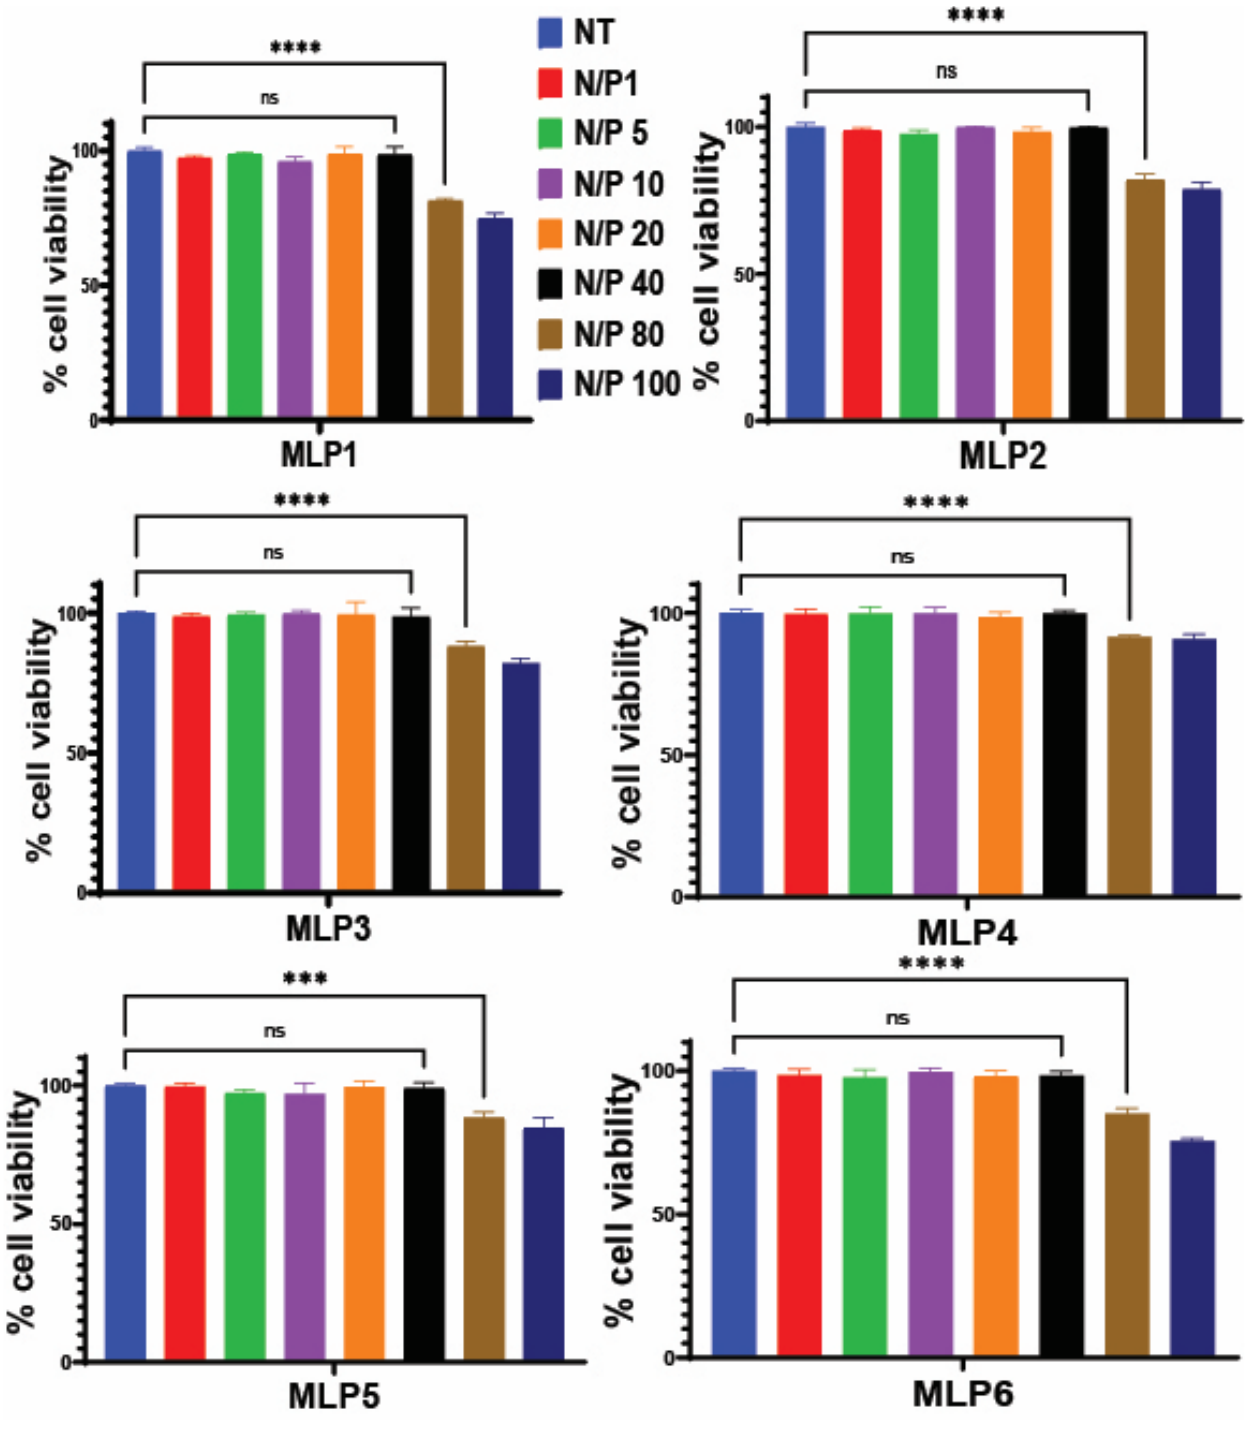
Figure 9. Cytotoxicity of peptide-siRNA complexes in MDA-MB-231 cells at different N/P ratios (incubation time: 48 h). Graphs represent mean normalized values (based on No Treatment, or the NT group, n = 3). Error bars indicate standard deviation. ns = non-significant ( p -value > 0.05), *** p -value < 0.0005 and **** p -value < 0.0001.